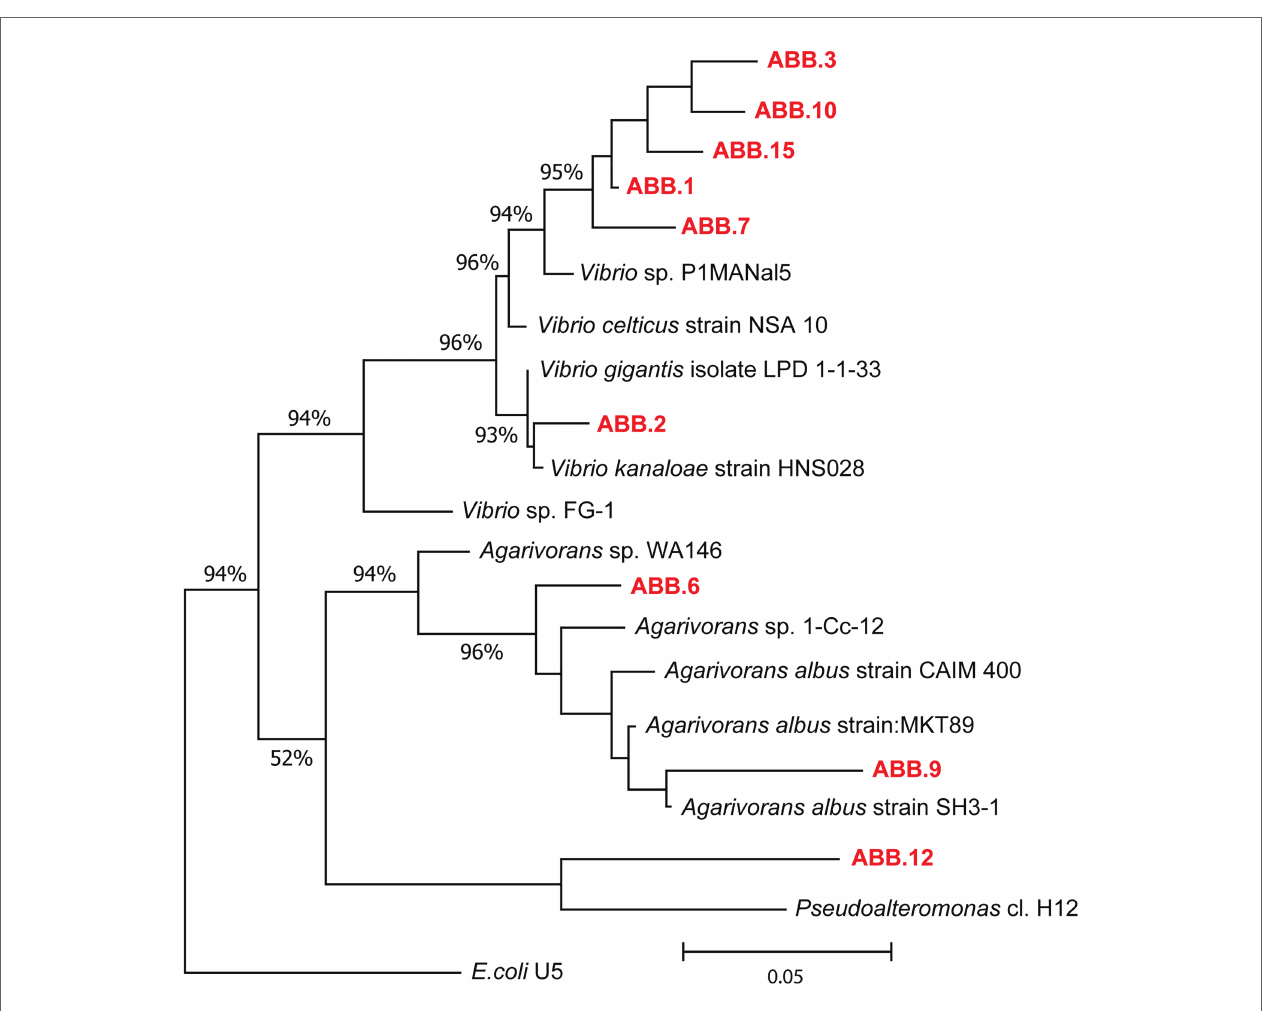
FIGURE 5 | Phylogenetic tree of the nine bacterial strains isolated from the sediments of the Bagnoli-Coroglio area. The tree shows the affiliations of the nine bacterial strains (highlighted in red, ABB.1, 2, 3, 6, 7, 9, 10, 12, and 15) based on 16S rRNA gene